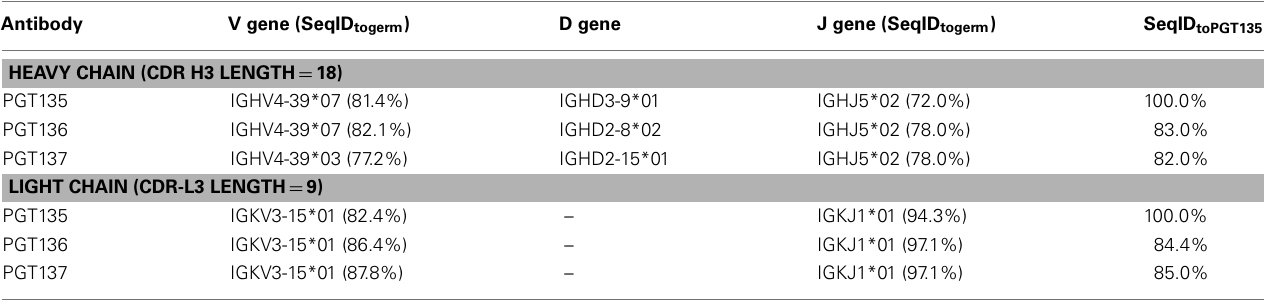
Table 3 | Recombination origins of antibodies PGT135–137.